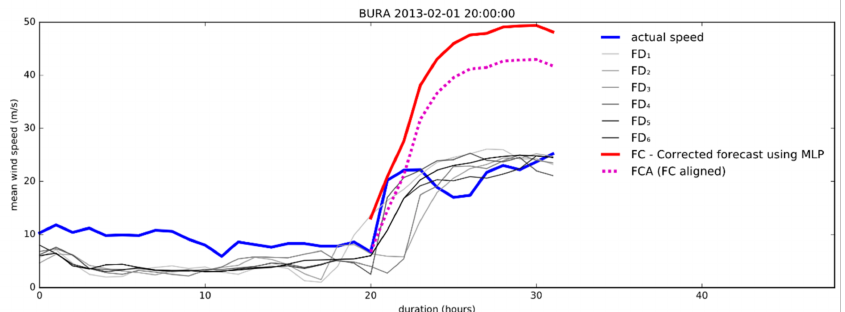
Figure 13. An example of the “Worse” category of the corrected forecast at the moment of a sudden large speed jump.